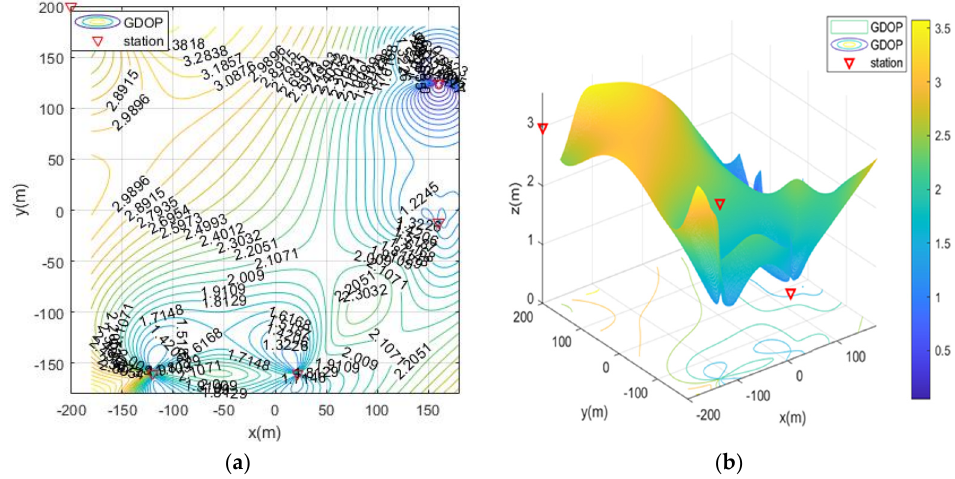
Figure 13. GDOP map of five base stations optimization results with a fixed station ( − 200, 200, 3) ( a ) 2D contour map of moa07; ( b ) 3D contour map of moa07.